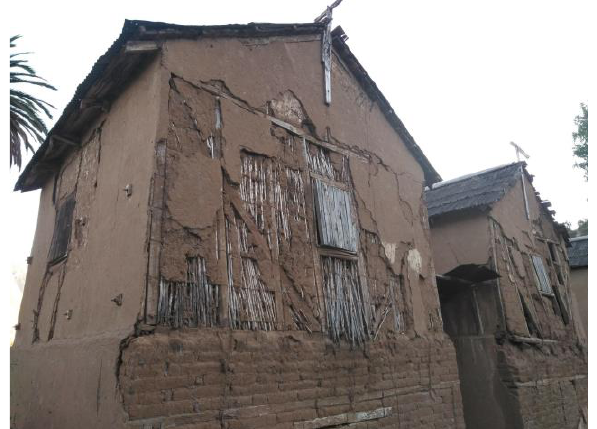
Figure 6. A singular case of ‘quincha ’ in Chalinga. The lower area is built with adobe.